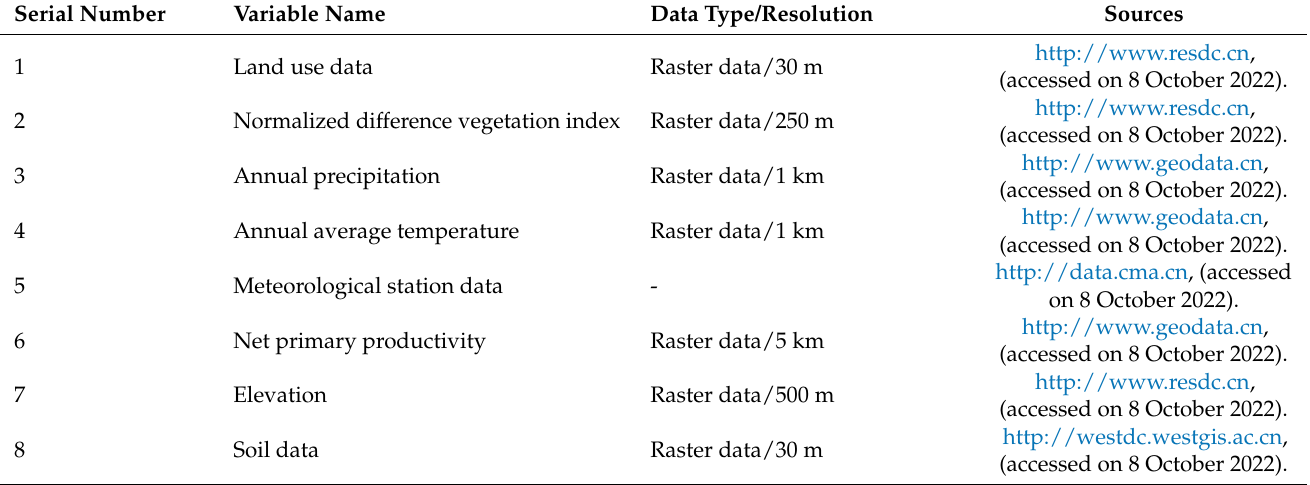
Table 1. Data sources in the